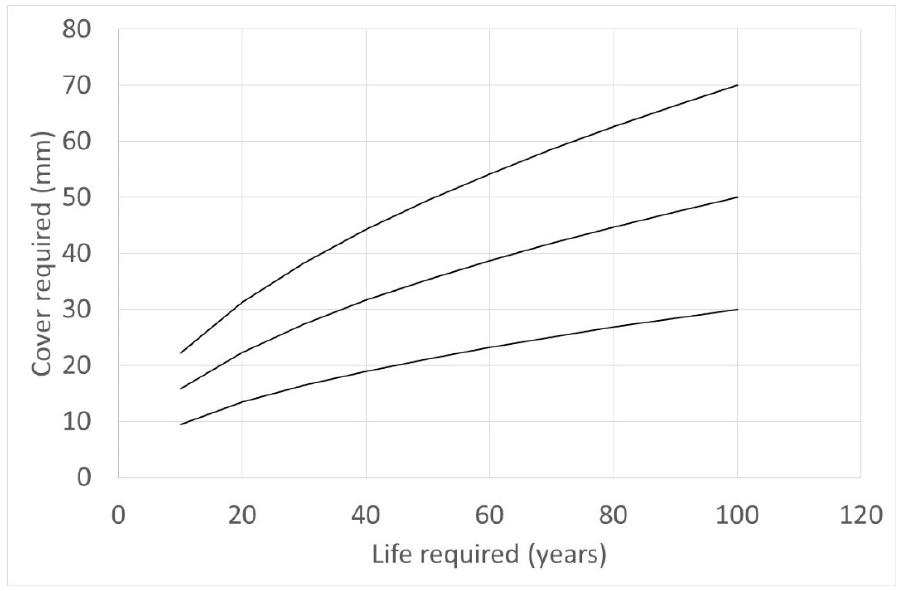
Figure 7. Cover (in mm) to achieve a given life.